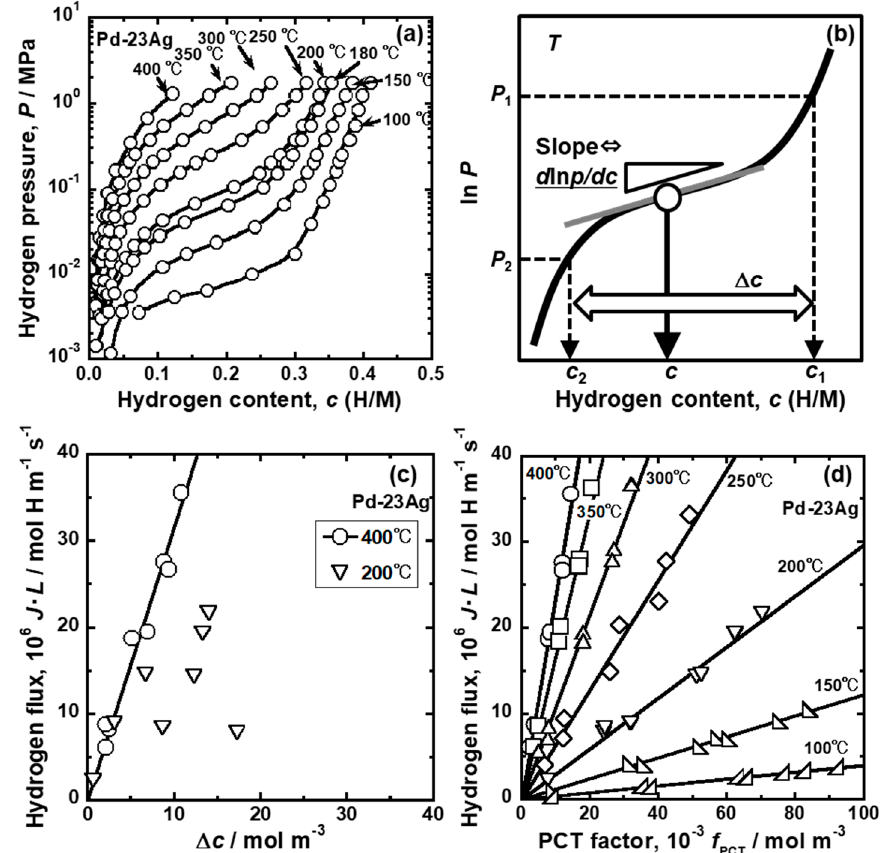
Figure 10. ( a ) Pressure–composition isotherms (PCT curves) for Pd-23 mol%Ag alloy, ( b ) schematic illustration of a PCT curve showing how to estimate the di ff erence in hydrogen concentrations between feed and permeation sides ( ∆ c ) and the PCT factor ( f PCT ), and ( c , d ) changes in the hydrogen flux normalized by the inverse of membrane thickness as functions of ( c ) ∆ c and ( d ) f PCT [27], with copyright permission from Japan Institute of Metal and Materials (JIM).